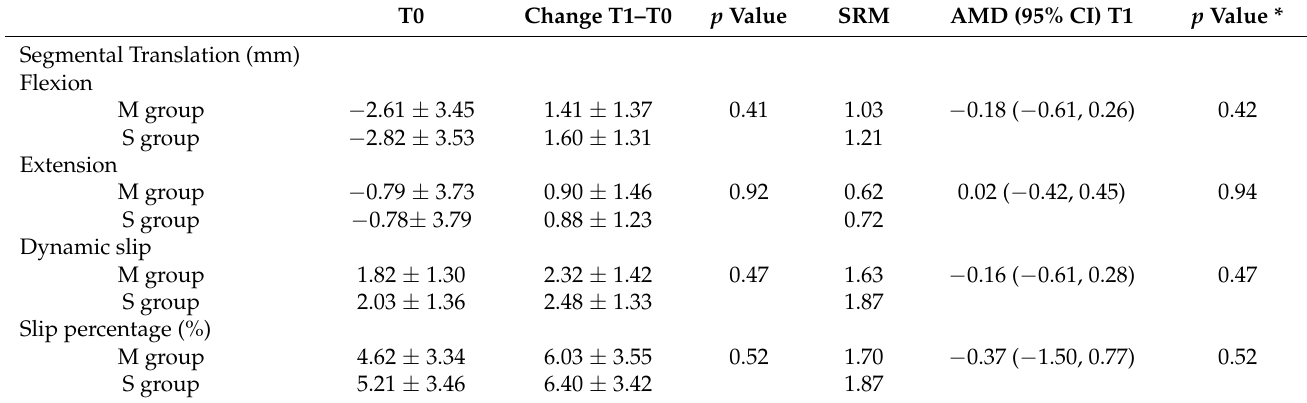
Table 3. Parameters measured from flexion/extension radiographs between moderate and severe pain groups.